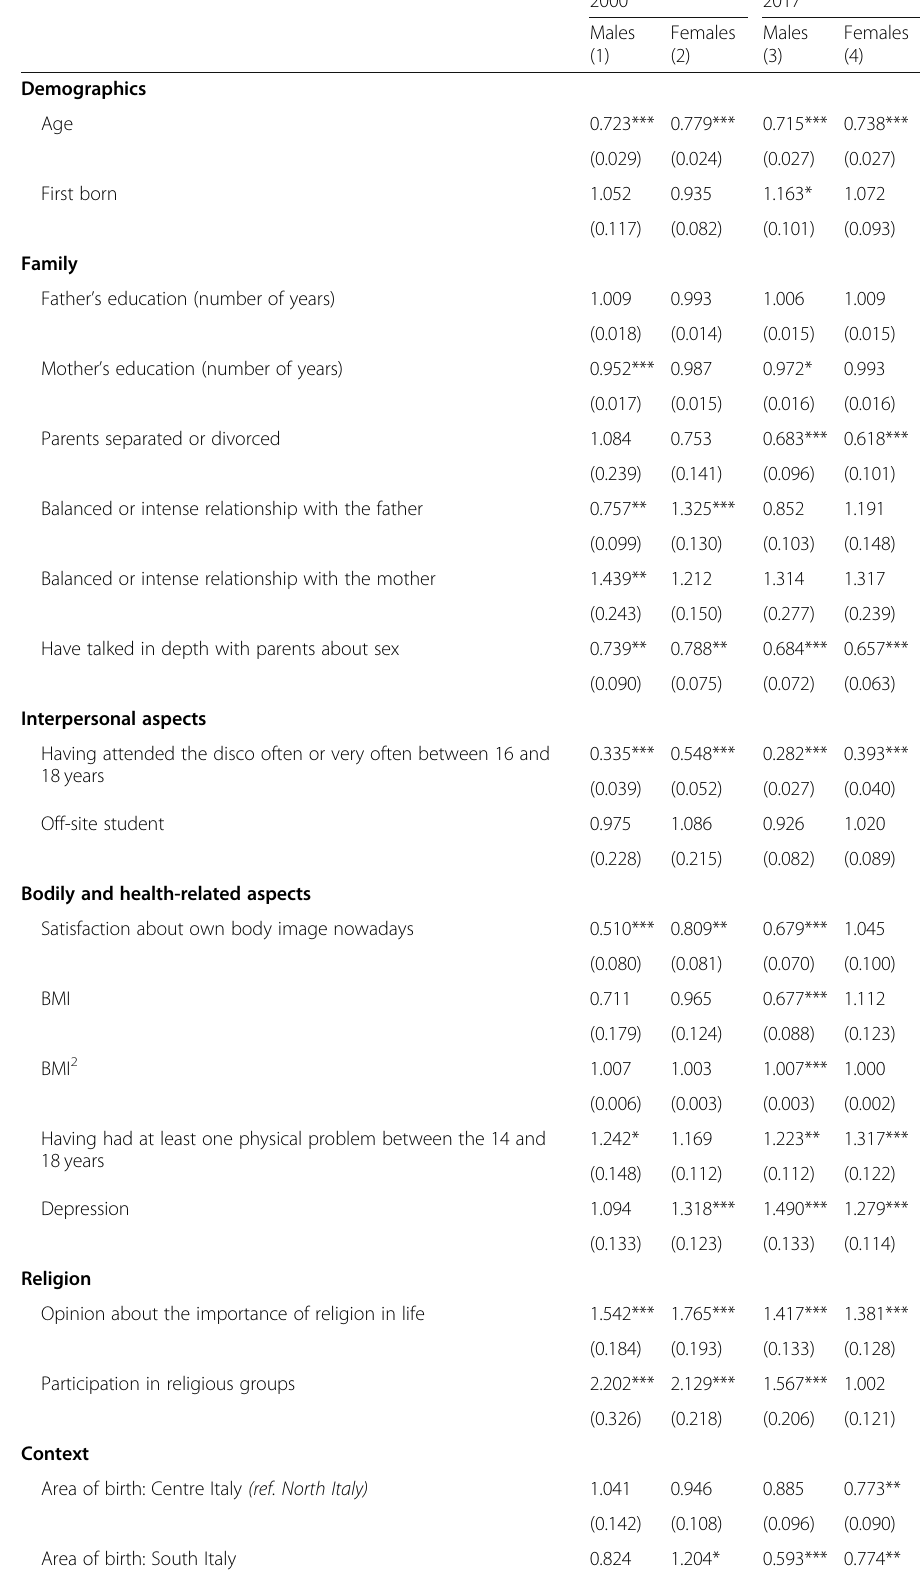
Table 2 Main models by year, odds